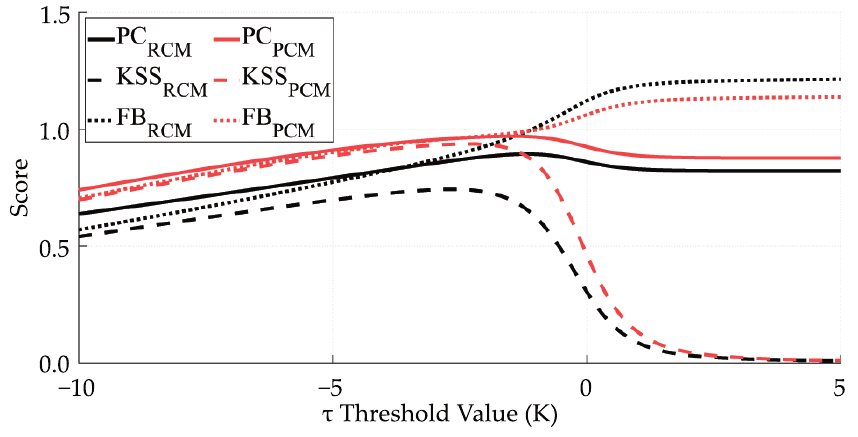
Figure 4. Different skills scores in function of the threshold value. midlatitude case.